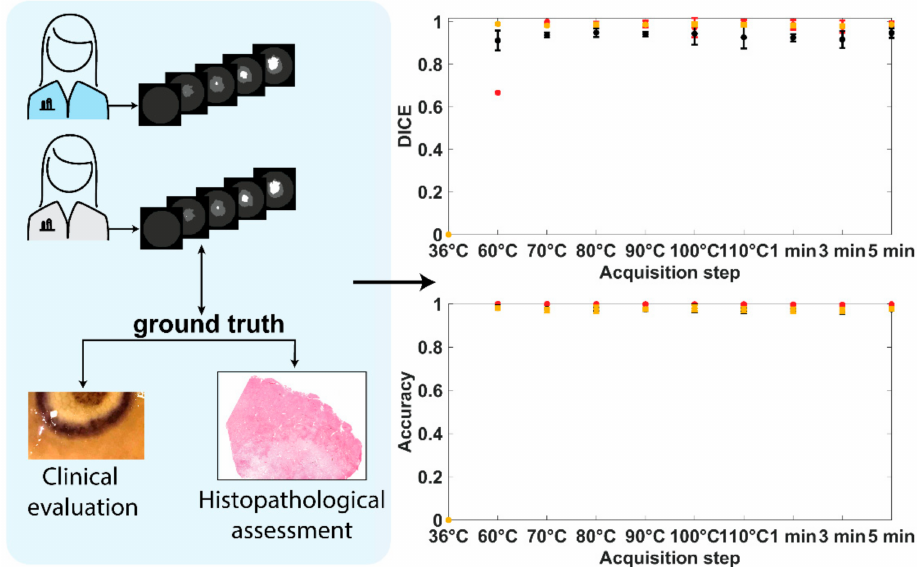
Figure 3. TDSM dataset creation. The manual segmentation was performed by visual inspection based on the color profile. Two annotators were used, and inter-annotator agreement was assessed with DICE and accuracy